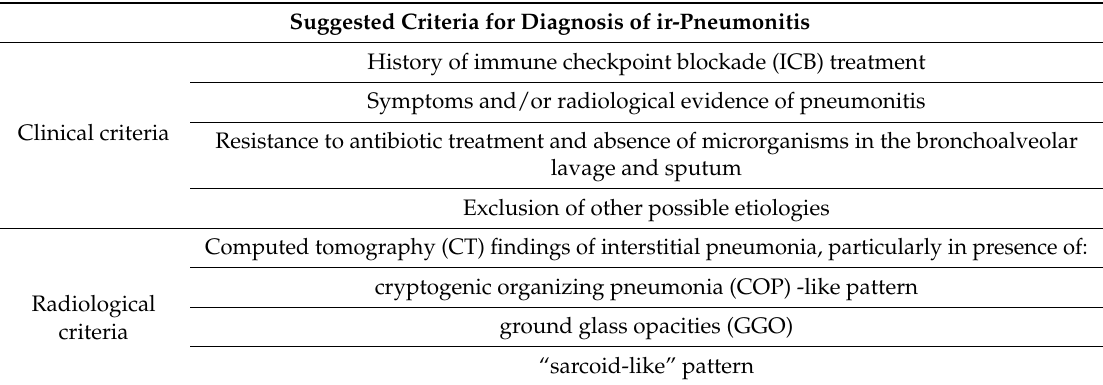
Table 3. Suggested criteria for diagnosis of